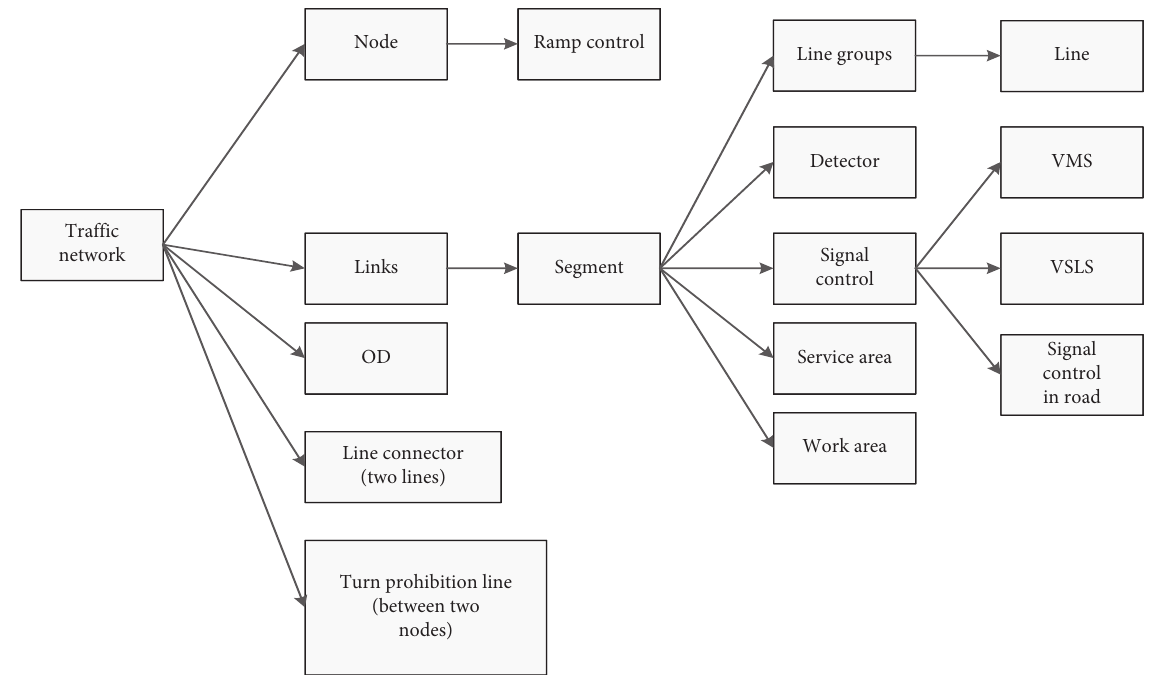
Figure 2: The relationship between network